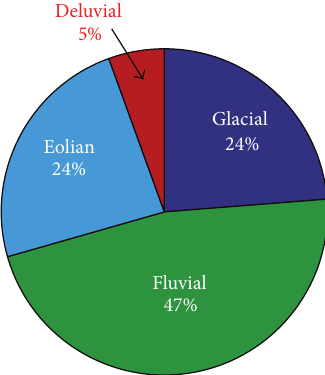
Figure 2: Percentages of the individual genetic types.